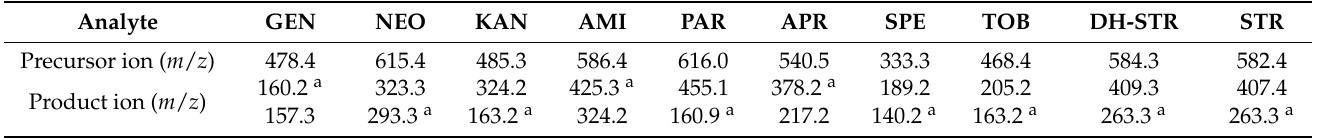
Table 1. MS parameters for monitored